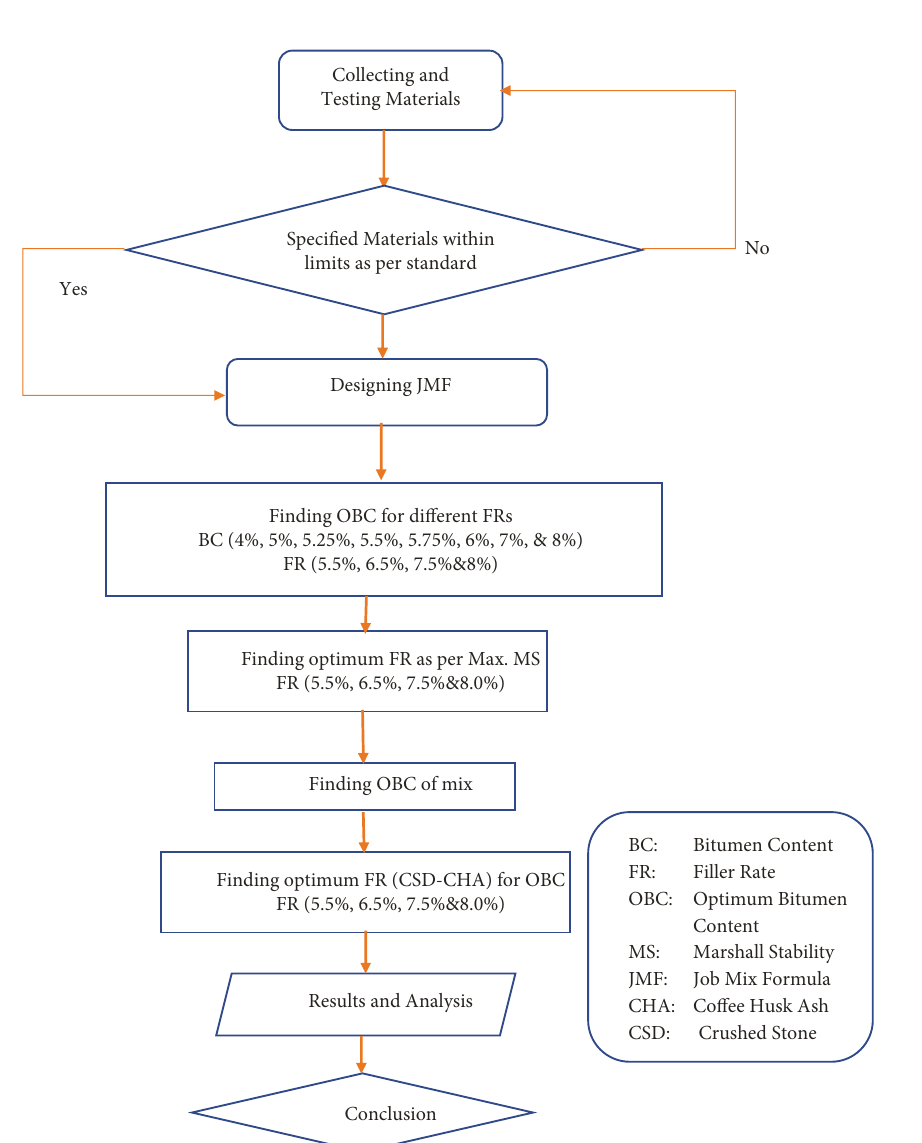
Figure 2: Flowchart of the experimental work.